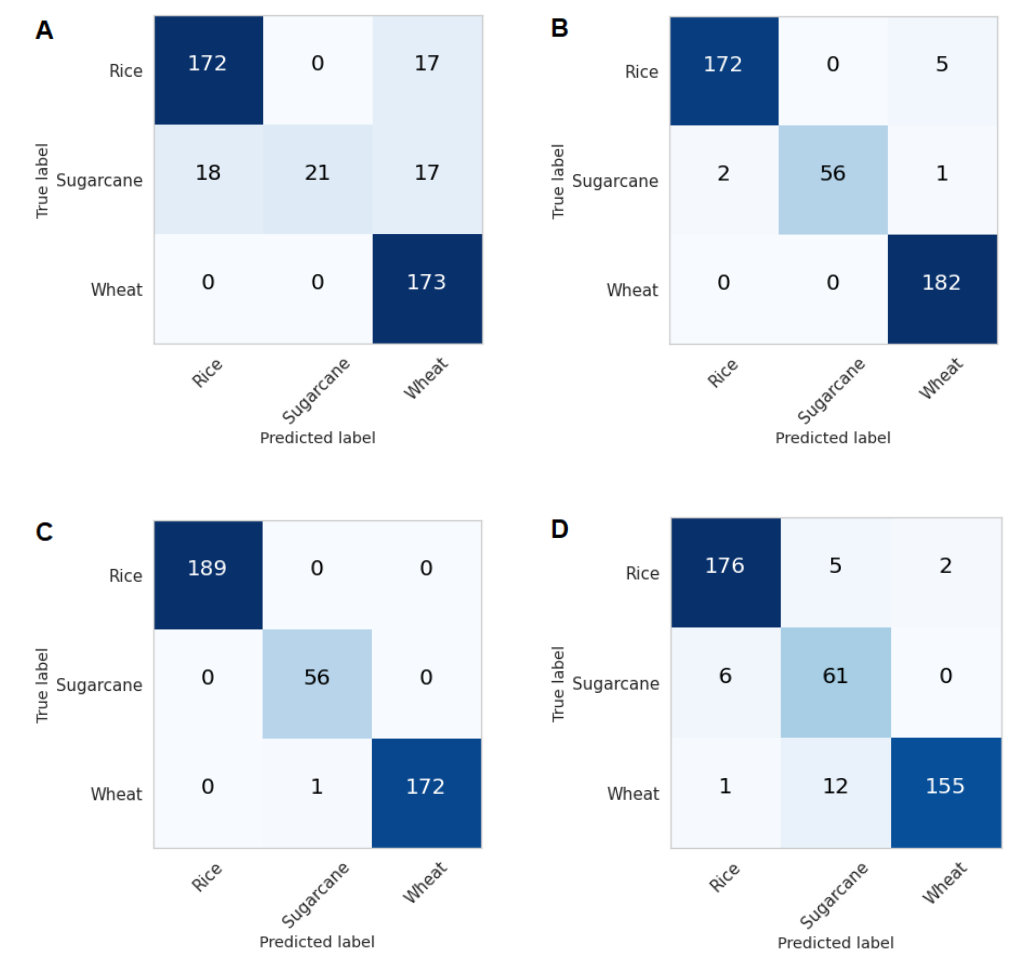
Figure 6. Confusion matrices of ( A ) Experiment 1, ( B ) Experiment 2, ( C ) Experiment 3, and ( D ) Experiment